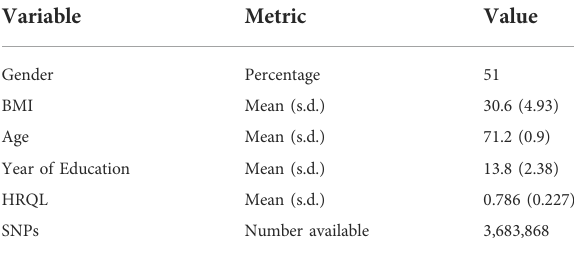
TABLE 2 Descriptive statistics for the Wisconsin Longitudinal Study. HRQL : Health related quality of life was measured by the Health Utility Index Mark 3. BMI: Body Mass Index. s.d.: Standard